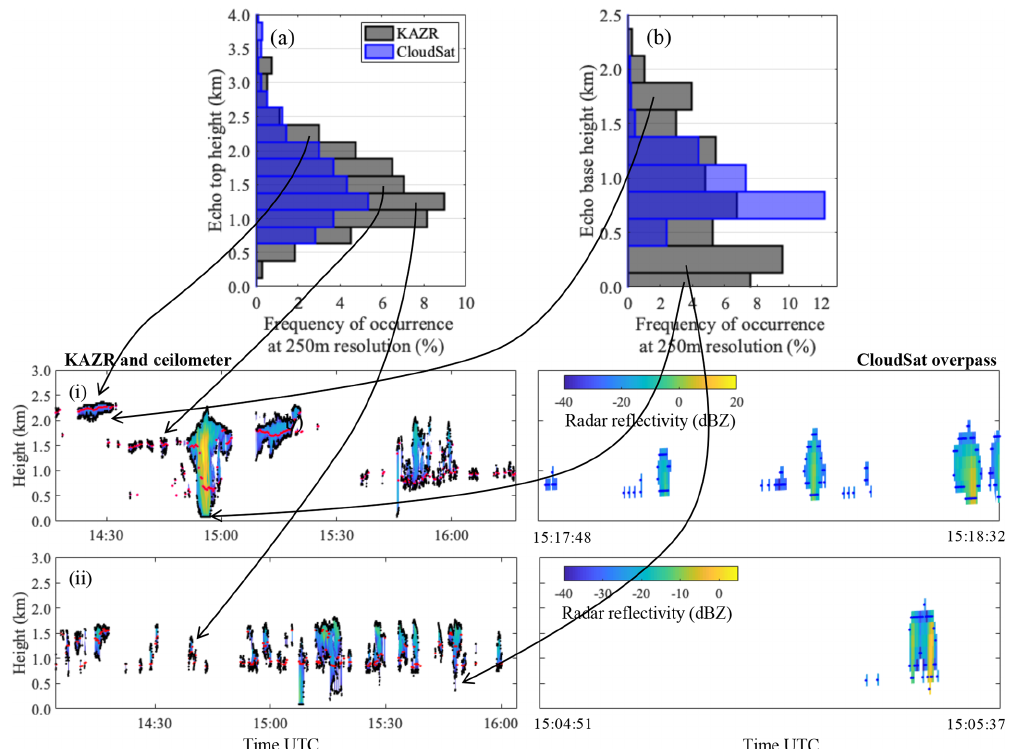
Figure 4. For 103 instances where CloudSat overpassed the 200km radius region centered on the ENA observatory, distribution of (a) echo top height and (b) echo base height, estimated from CloudSat CPR observations within a 200km radius of the ENA observatory (blue) and ground-based KAZR observations collected within ± 1h of the CloudSat overpass (grey). For references are examples of hydrometeor radar reflectivity measured on (i) 11 February 2017 and (ii) 24 October 2016 by the ground-based KAZR within ± 1h of the CloudSat overpass and by the CloudSat CPR within 200km of the KAZR location. Dots on these figures represent the boundaries of the radar echo (black and blue dots for the KAZR and the CloudSat CPR, respectively) and the location of the ceilometer-determined cloud base (red